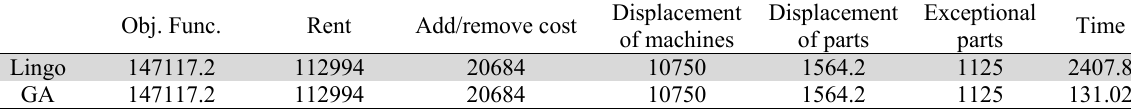
Add/remove cost Rent Obj.